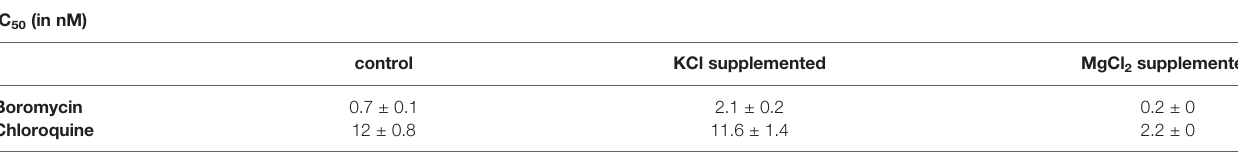
TABLE 5 | Activity of boromycin and the control drug chloroquine against the P. falciparum strain 3D7 in the presence/absence of KCl (220 µg/ml) and MgCl 2. (220 µg/ml). IC 50 (in